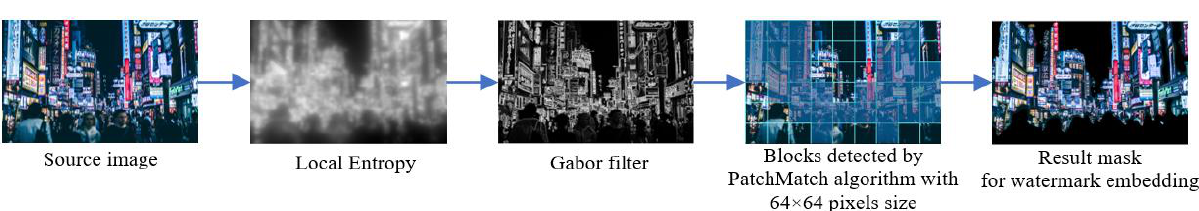
Figure 1 . Selecting the relevant regions in the frame set. The main stages of the algorithm are texture analysis and motion analysis. After that, we use the PatchMatch algorithm to select the high-textured blocks with less motion. The size of blocks varies depending on the frame size and the desirable resource cost.